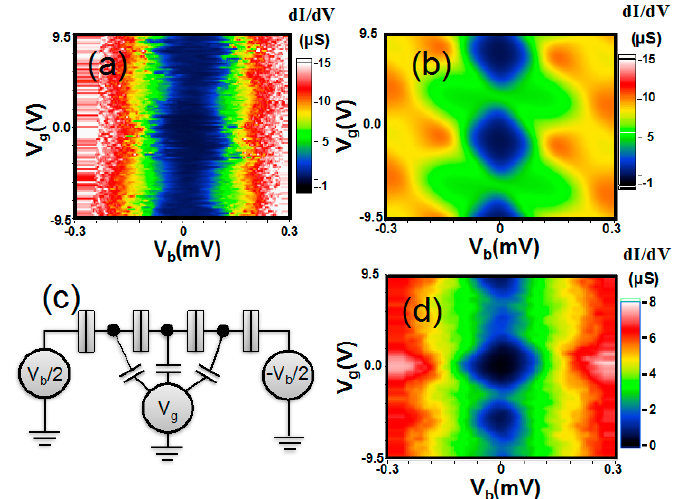
Figure 9. ( a ) the experimental data of dynamical conductance for a different MPA AI device; ( b ) the calculated dynamical conductance of a single-island SET circuit; ( c , d ) the assumed three-island circuit and calculated dynamical conductance.